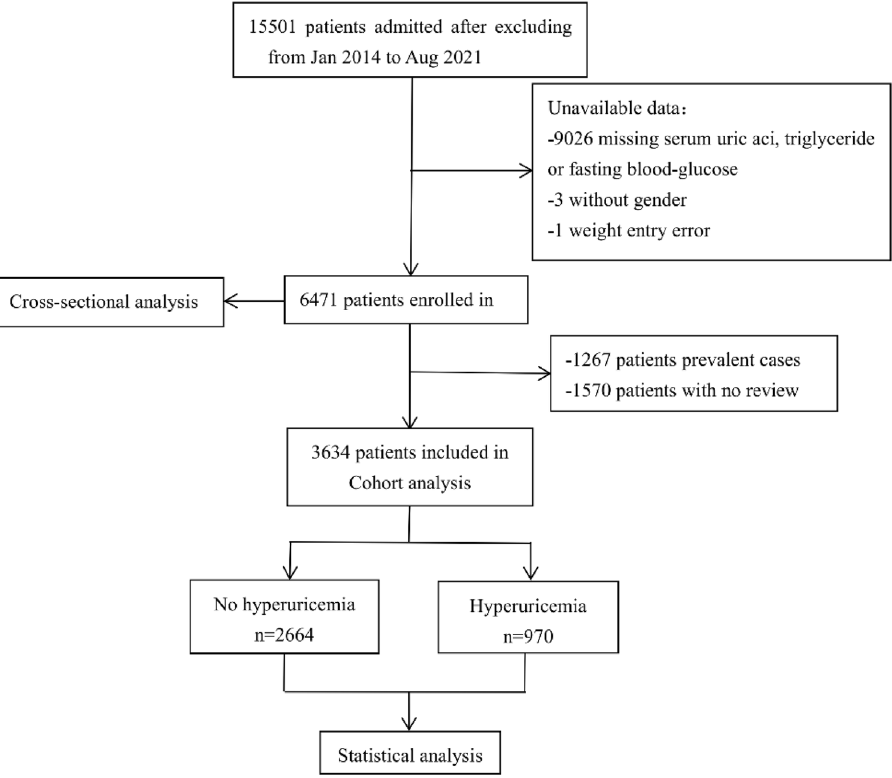
Figure 4. Flow chart of subject selection for this